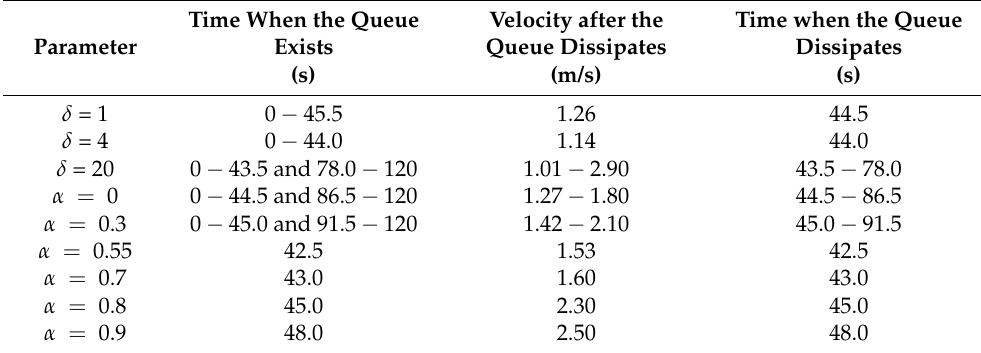
Table 5. Velocity and time for the ID and proposed models during the queue and after the queue dissipates.